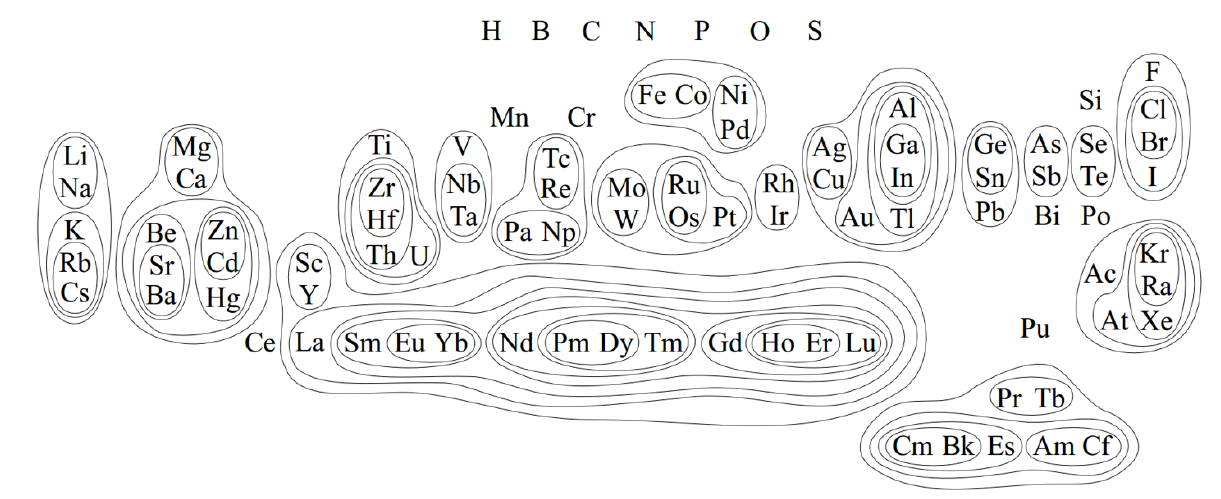
Figure 1. Most relevant similarity classes for 94 chemical elements obtained by analyzing binary compounds. Elements are spread on the plane trying to keep their positions as those depicted in the current middle-form periodic table while at the same time spatially indicating nearness in .behavior, expanding on the traditional grid. Sets and subsets group elements by similarities. Pairs of similar elements are denot- ed by subsets of two elements. Whenever a subset belongs to a larger subset, this indicates a hierarchical similarity. For example, Rb and Cs are similar elements, which in turn hold a more relaxed similarity regarding